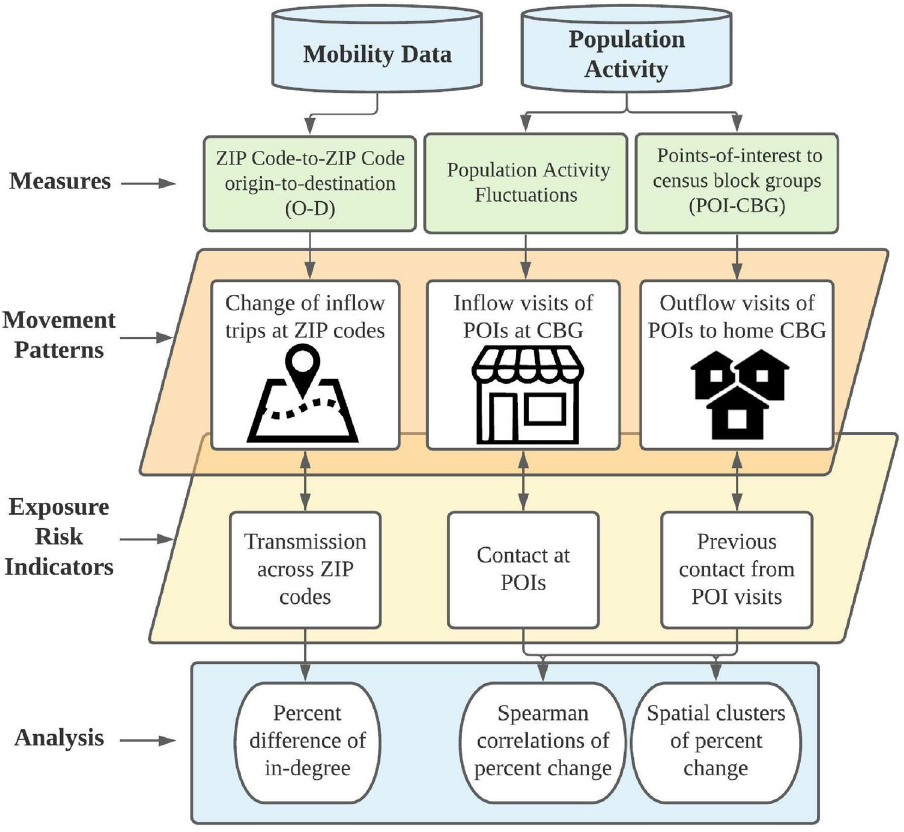
Figure 2. Method process of mobility data population activity from data collection to data